Question: What kind of plot is shown here?
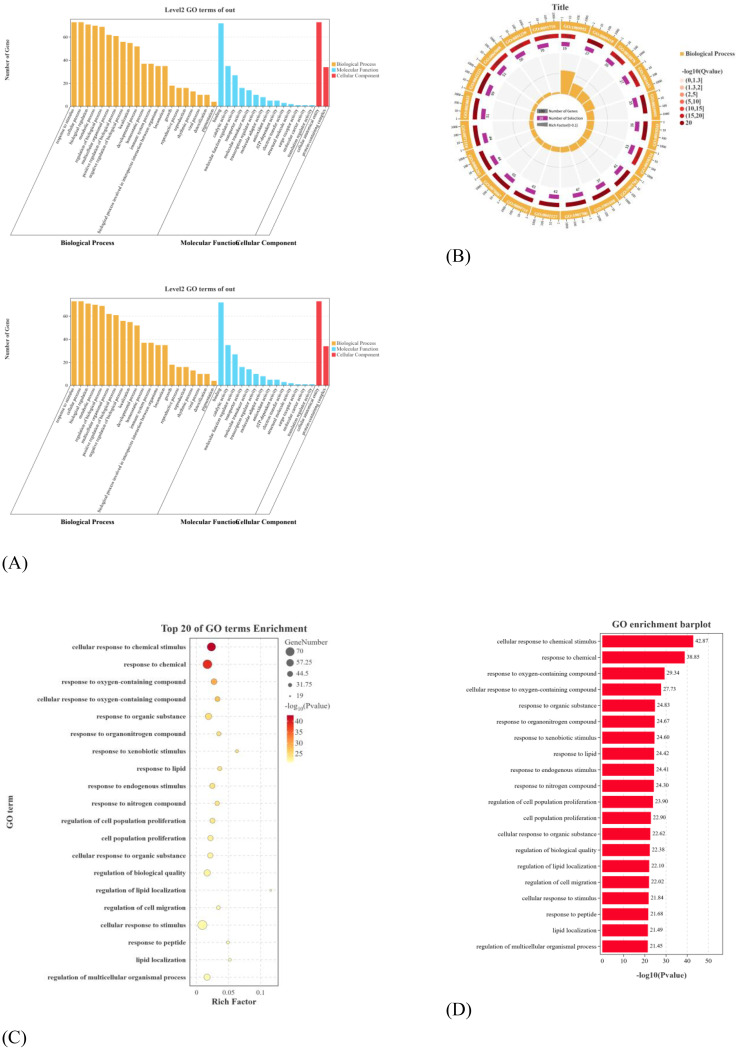
Answer: histogram